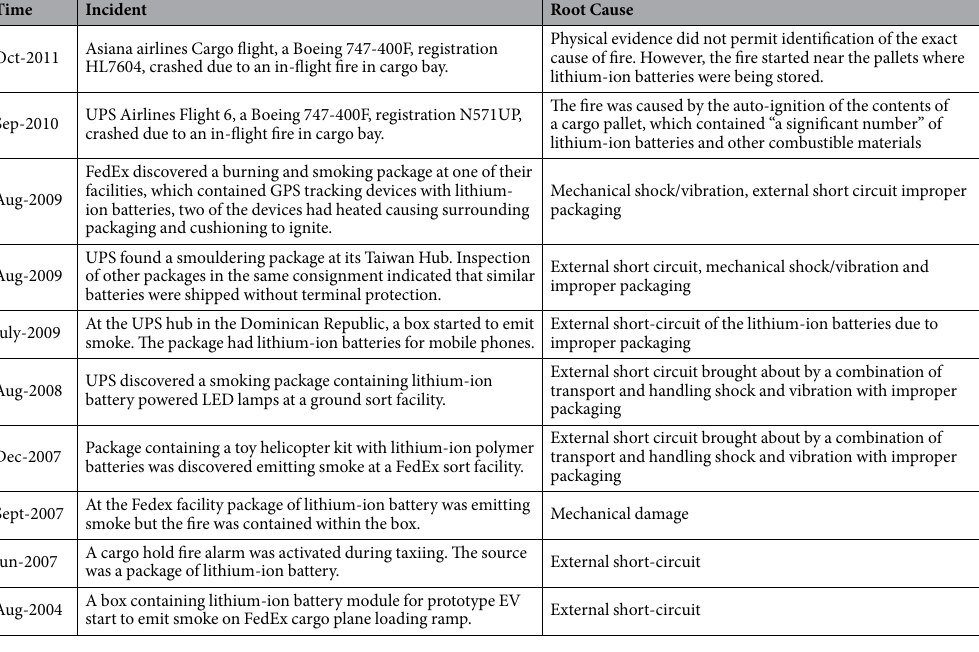
Table 2. List of air-cargo/air-side transport incidents attributed to lithium-ion batteries and devices containing lithium-ion batteries 32, 41–45